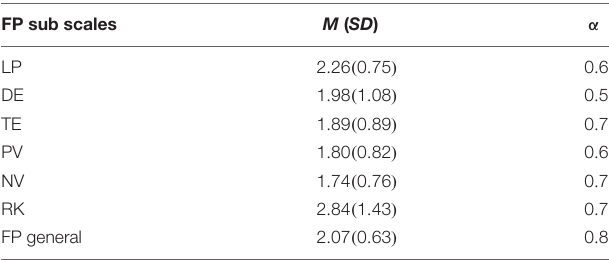
TABLE 7 | Means, standard deviations and Cronbach- α reliabilities of FP subscale, as obtained in Study